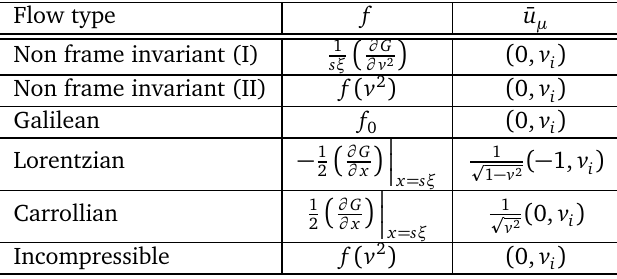
Table 1: Values of f and ¯ u µ which determine Ω µν = ∂ µ ( f ¯ u ν ) − ∂ ν